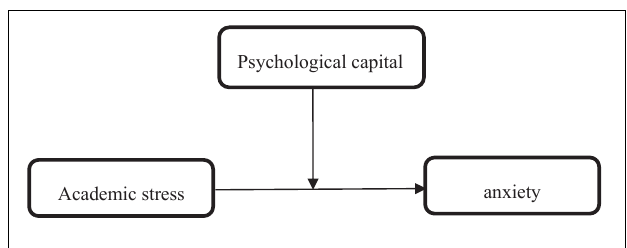
FIGURE 2 | Moderation